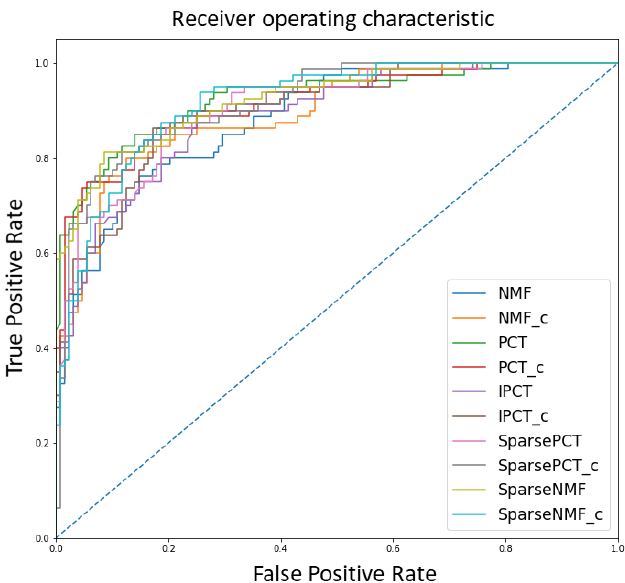
Figure 5. The receiver operating characteristic (ROC) curves of different embedding approaches used with SPAER, both with and without adding demographics.